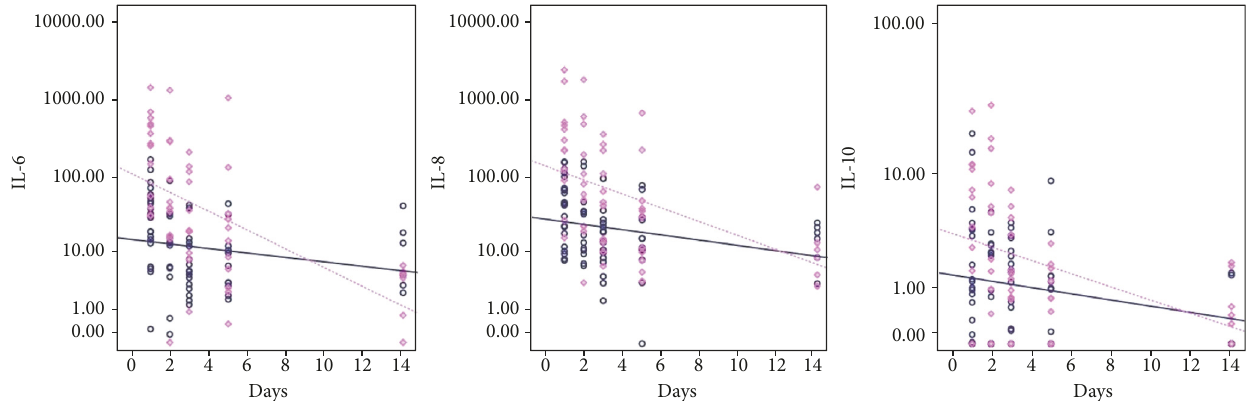
Figure 2: Fitting lines of IL-6, IL-8, and IL-10 (base-10 log scale) for the occurrence of sepsis (dashed line and diamonds) or not (solid line and circles) on days 1, 2, 3, 5, and 14 of the onset of fever.